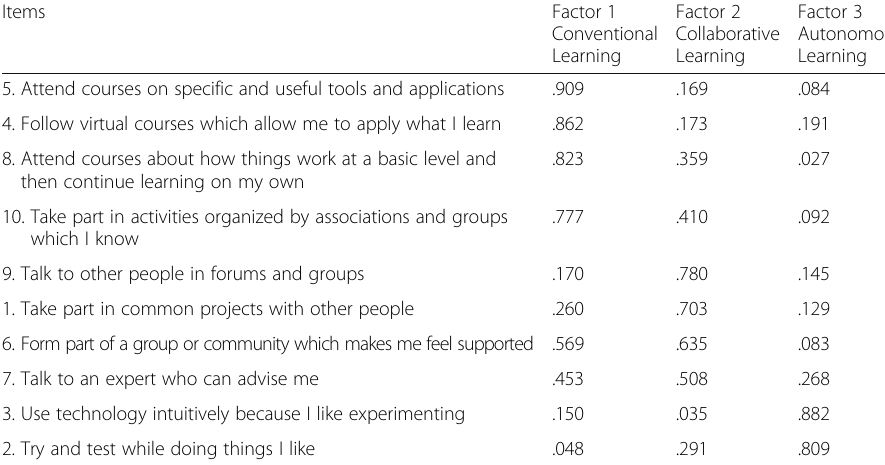
Table 2 Rotated component matrix of learning strategies